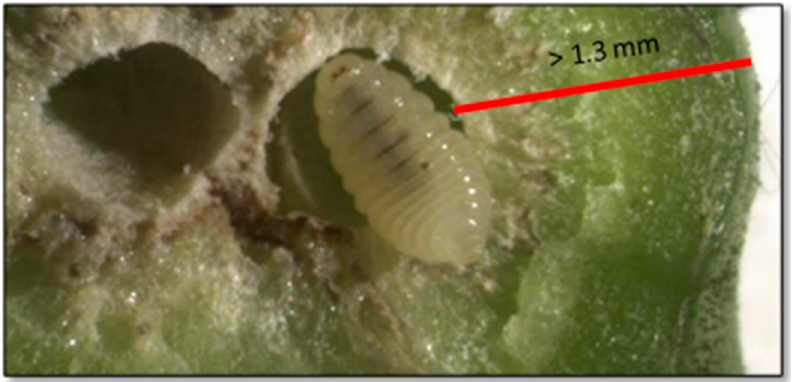
Figure 1. Example of the location of a larval chamber. The minimum depth was calculated in a representative sample of galls (N = 50) to set the depth of the needle in the deformation tests. For each test, the distance-force curve was acquired at 500 points per second, and the following parameters were determined (Figure 2): F1 (force opposed at the first force peak, Newton (N)), W1 (energy opposed between the initial test point and the first force peak, milliJoule (mJ)), E1 (force gradient between the initial test point and the first force peak, N/mm), F2 (force opposed at the end of the test, i.e., after 1 mm of deformation, N), W0-2 (energy applied during the whole test, mJ), E0-2 (force gradient between the initial and the final test point, N/mm), Fmax (maximum force applied during the whole test, N) (Figure 2).